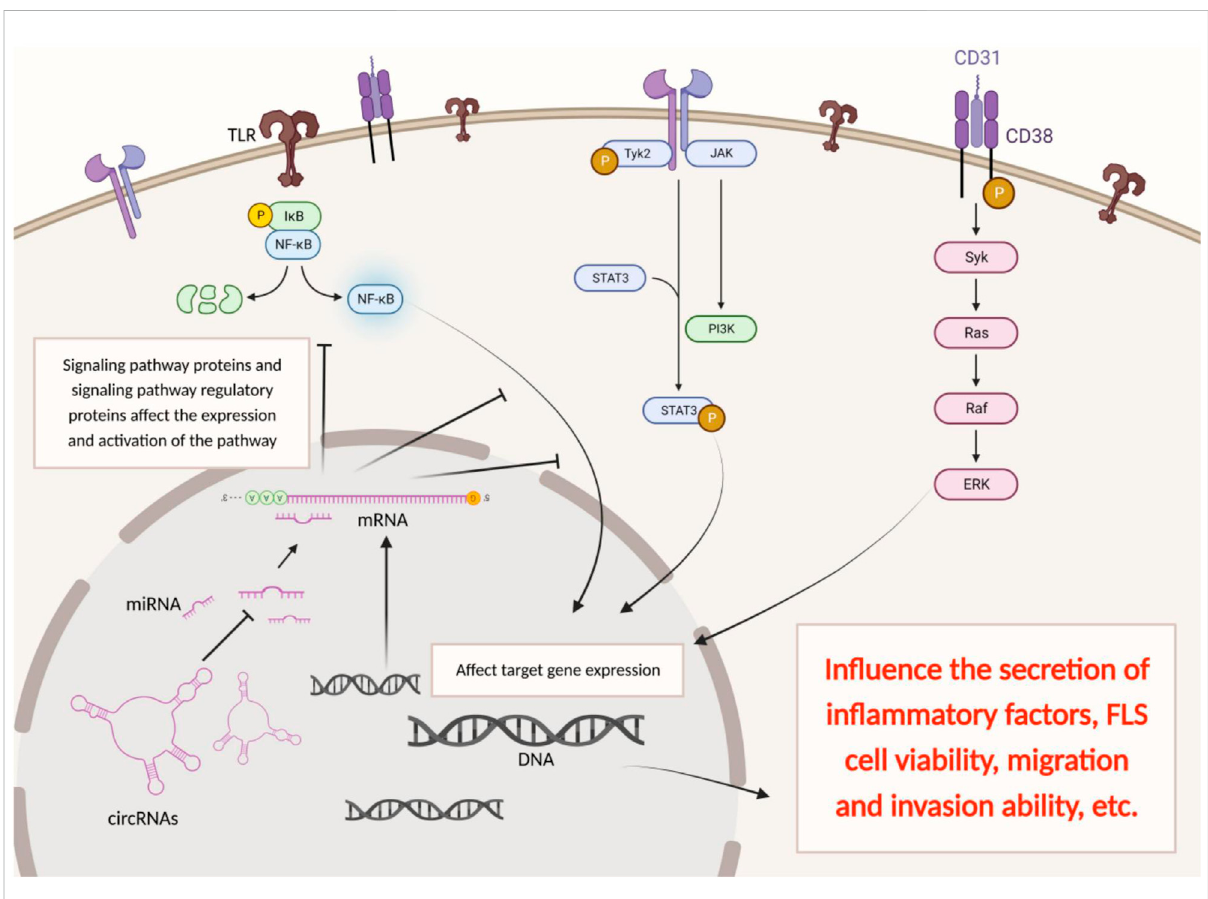
CircRNAs have multiple functions and can be involved in the pathogenesis of RA through multiple